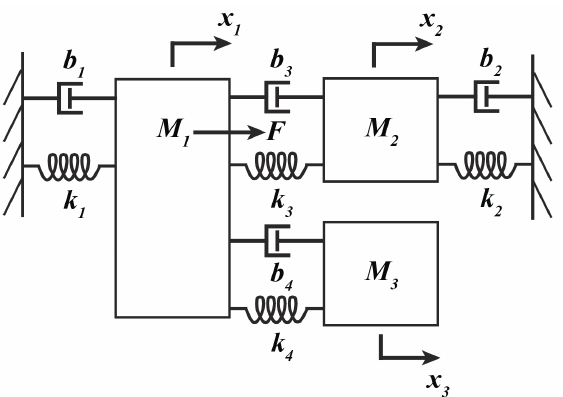
Figure 4. A linear mass–spring-damper model of the connection between the OHT vehicle, the hand unit, and the